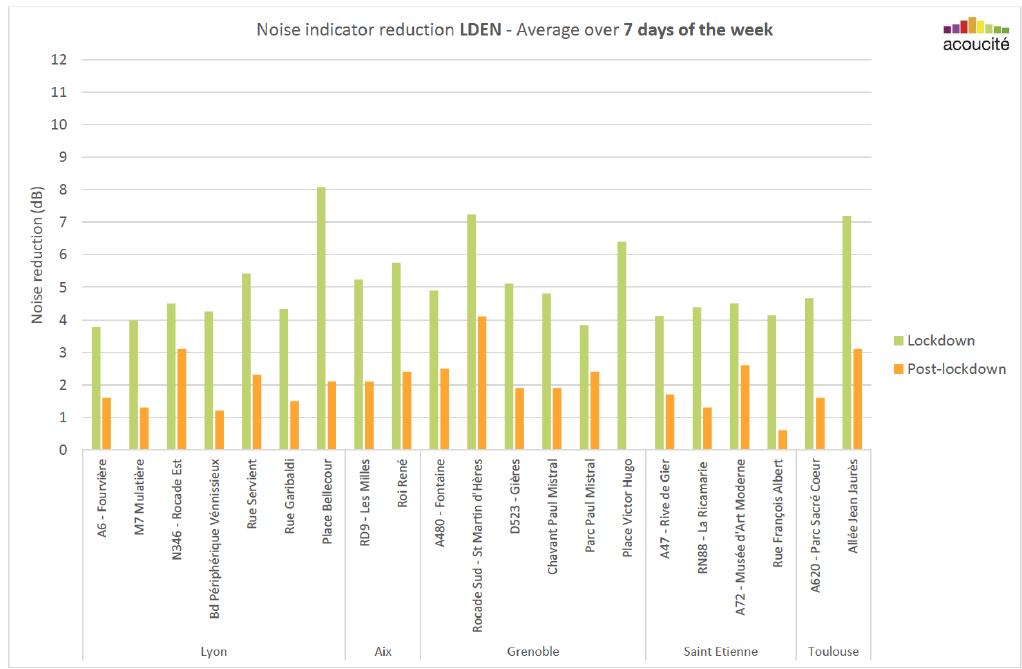
Figure 7: Comparison between the sound level reduction observed during the lockdown period (green) and during the first two weeks after lockdown lifting (orange). For the case of Place Victor Hugo in Grenoble, this is not a reduction equal to 0 dB after lockdown lifting but an absence of data for this